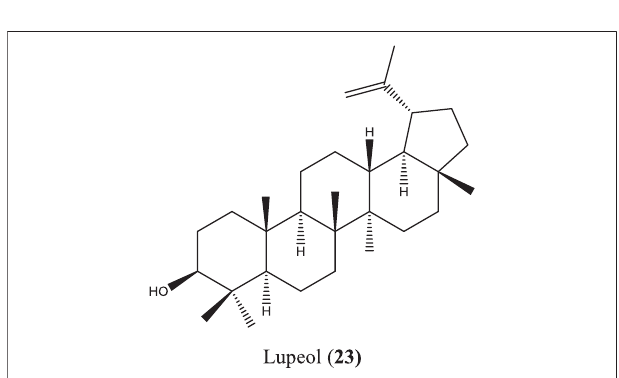
( Figure 4 ), kaempferol ( 20 ), catechin ( 21 ), epicatechin (Perez, 2001; García-Mediavilla et al., 2007; Hämäläinen et al., 2007; Kim SH. et al., 2015; Lesjak et al., 2018), and apigenin C-glycosides (e.g., vicenin-1) ( 22 ) (Li et al., 2018) ( Figure 7 ). A total fl avonoid